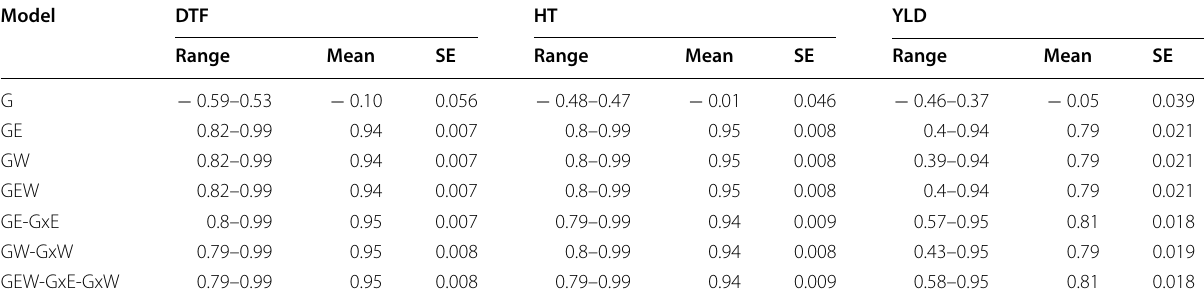
The average values are computed from predictive ability across 33 lines in each model